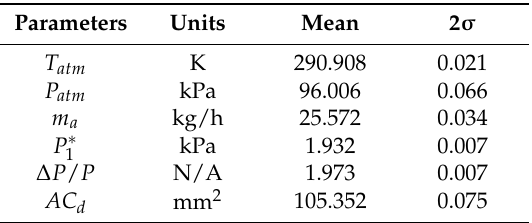
Table 2. Repeatability